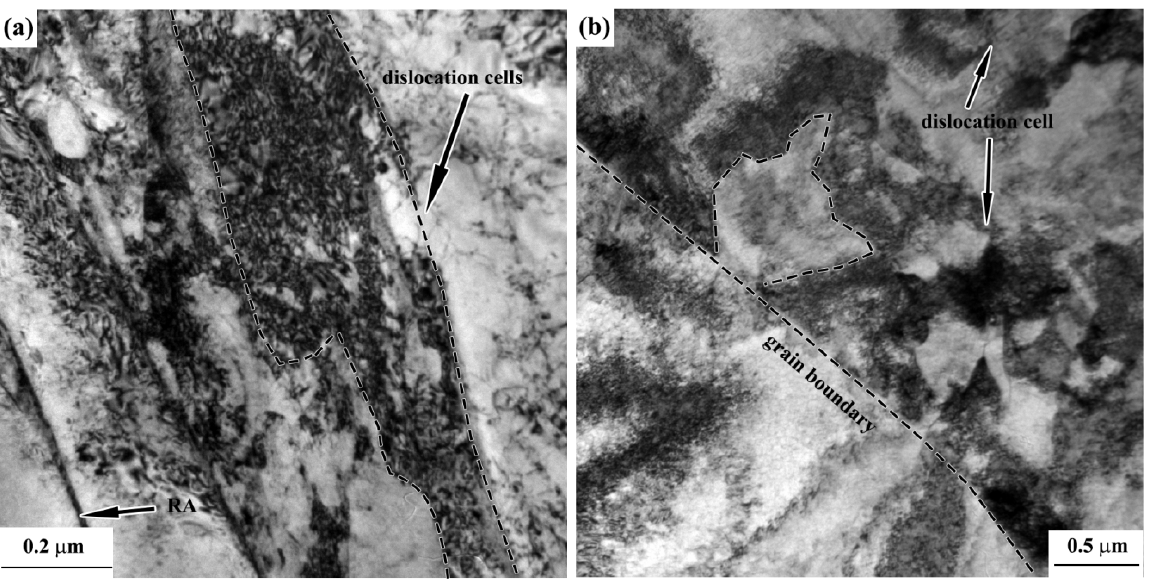
Figure 9. Dislocation observations of ( a ) 22MnSi2CrMoNi and ( b ) 00Ni18Co9Mo4Ti steels after fracture at 1.0% total strain amplitude.